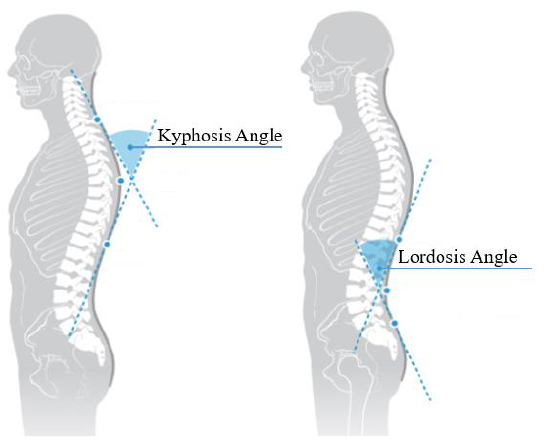
Figure 4. The angles of the kyphosis and lower back lordosis [30].